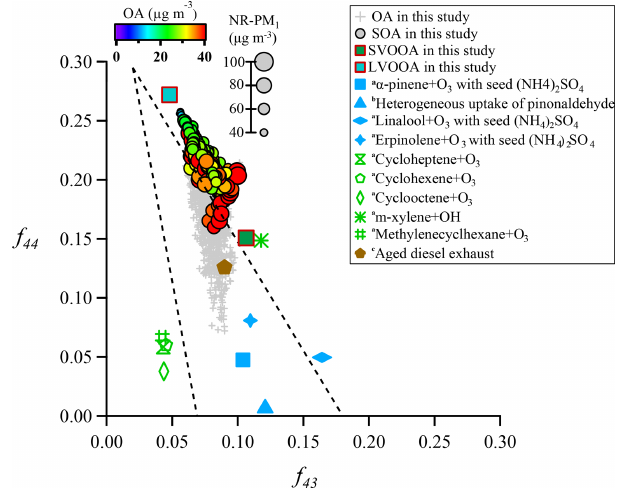
Figure 8. Dependences of SPM / PPM ratio, concentrations of the atmospheric oxidants (O 3 and RO ∗ ) on NR-PM 1 mass loading for Figure 9. Plot of f 44 vs. f 43 for this study, along with several 2 (a) entire study, (b) non-pollution period, and (c) pollution EPs. The laboratory studies ( a Bahreini et al., 2005; b Liggio et al., 2005; c Weitkamp et al., 2007). SOA is color-coded by OA mass concen- binned data are also presented as solid circles with an interval of 10µgm − 3 NR-PM 1 . The error bars are standard deviations. tration, and the size of a circle is proportional to the corresponding NR-PM 1 mass concentration. The triangle area (enclosed by two black dashed lines and the f 43 axis) for ambient OOA (SOA) was defined by Ng et al.